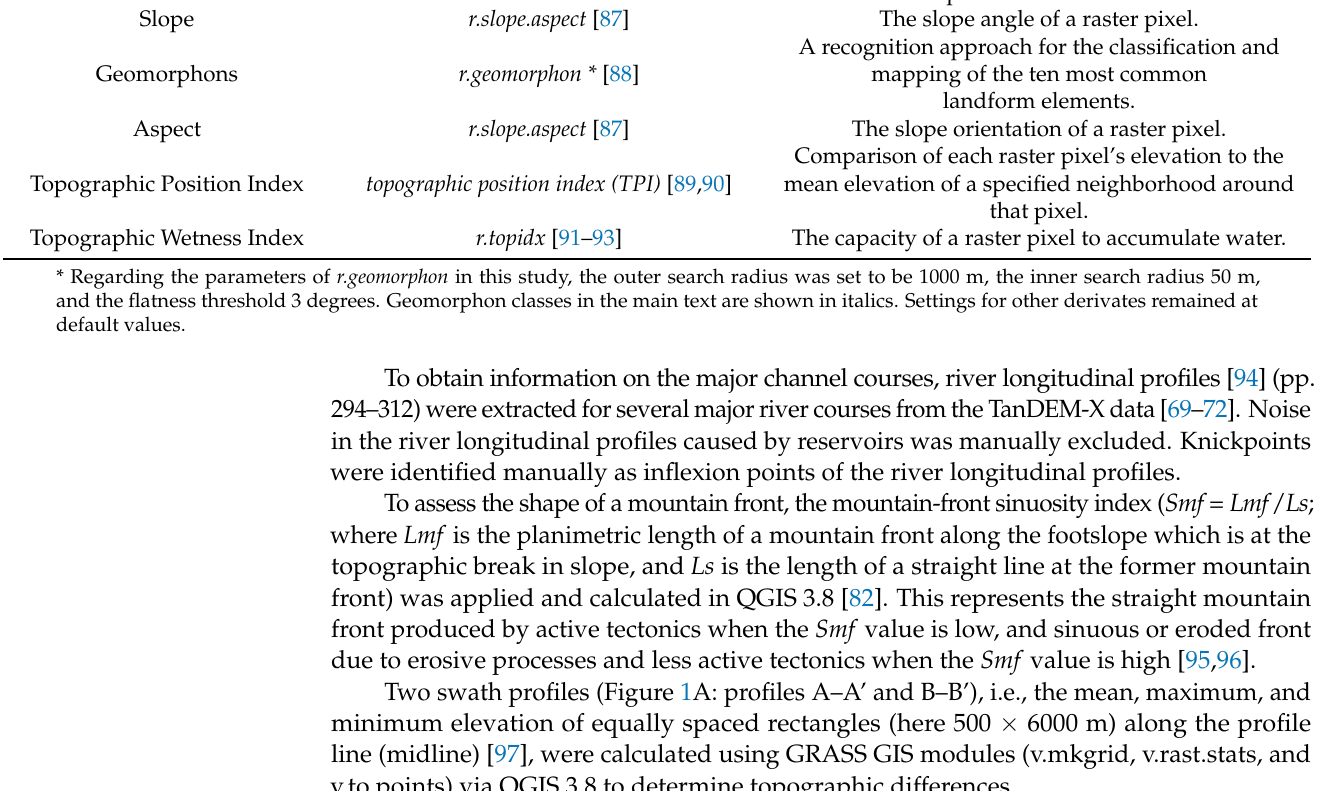
Table 1. Geomorphometric derivates (based on TanDEM-X data [23,24]) used for the identification of landforms in this study. Derivate Module Interpretation Shaded relief Hillshade Shaded relief representation of the terrain surface. Slope r.slope.aspect [87] The slope angle of a raster pixel. A recognition approach for the classification and Geomorphons r.geomorphon * [88] mapping of the ten most common landform elements. Aspect r.slope.aspect [87] The slope orientation of a raster pixel. Comparison of each raster pixel’s elevation to the Topographic Position Index topographic position index (TPI) [89,90] mean elevation of a specified neighborhood around that pixel. Topographic Wetness Index r.topidx [91–93] The capacity of a raster pixel to accumulate